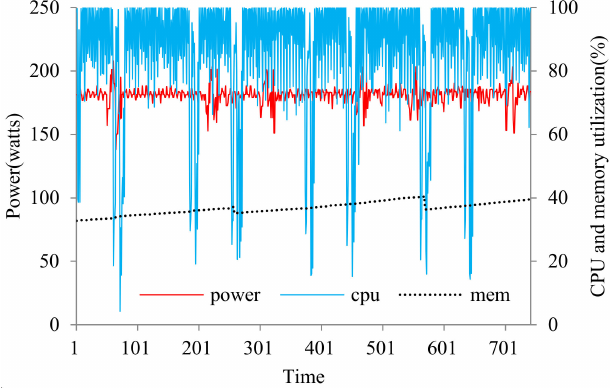
Figure 9. Power and utilization of in memory analytics on server